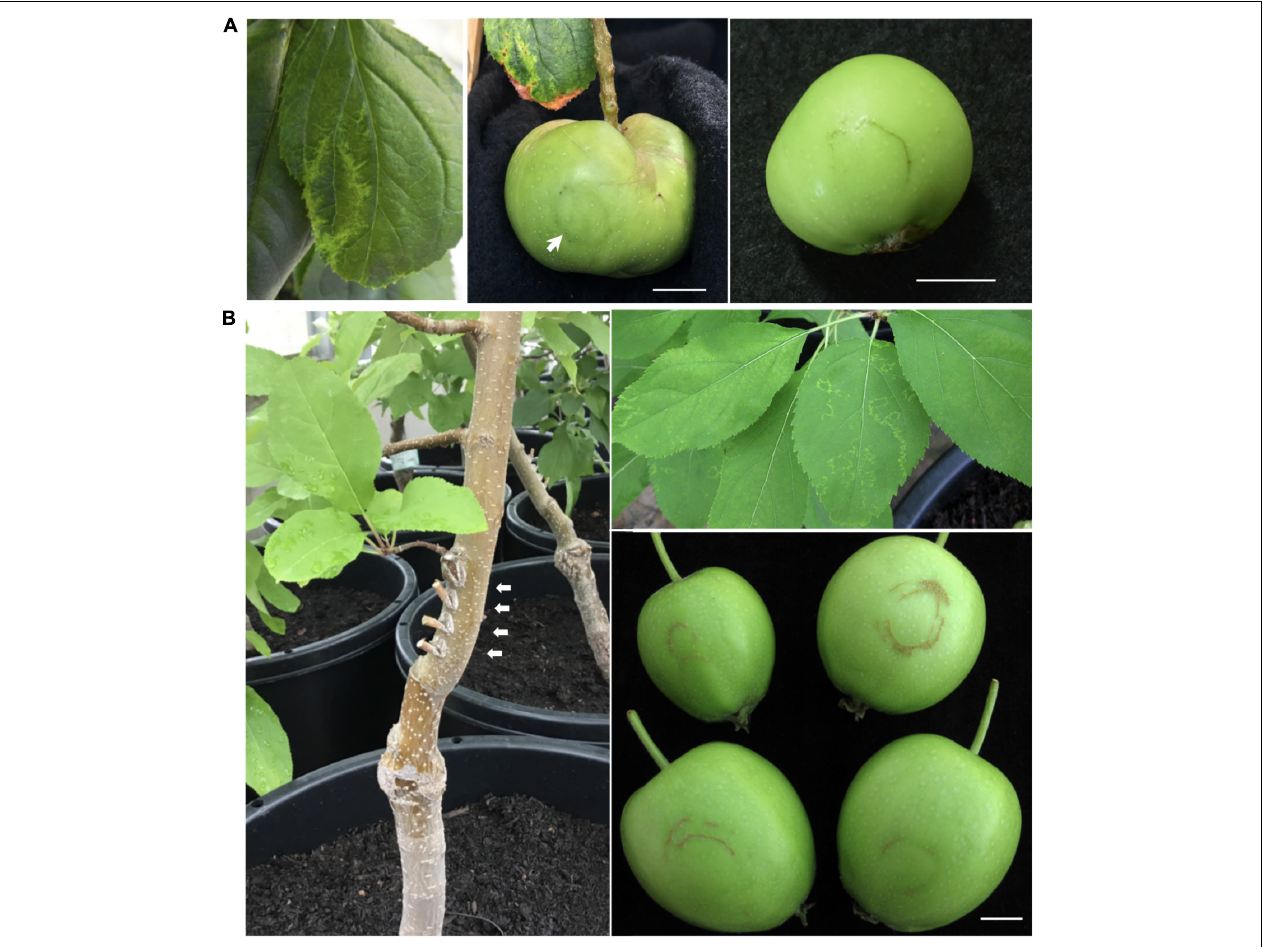
FIGURE 2 | Symptoms of the apple plants inoculated with ACLSV-RRACV 2. (A) Ring pattern of chlorosis on a leaf (left) and ring pattern on the fruits (center and right) of apple seedlings co-inoculated with RRACV2 and ALSV-AtFT/MdTFL1. (B) An apple tree (‘Golden delicious’) 3 years after grafting with cut branches infected with ACLSV-SV. Arrows in a left photo indicated the positions of grafting. Ring and line patterns of chlorosis on leaves of an apple tree (AP2) infected with ACLSV-RRACV2 (upper right) and young fruits showing russet-ring symptom on an apple tree (AP2) infected with RRACV2 three years after grafting (lower right). Scale bar; ca. 1